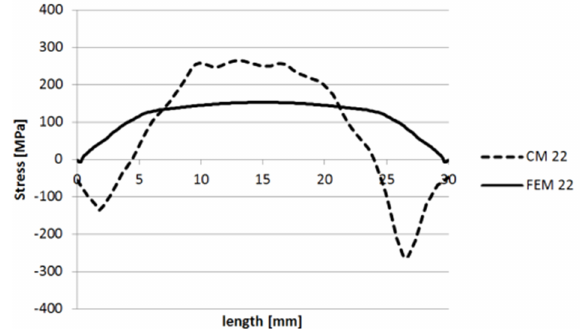
Figure 35. Stress levels in 22 direction along the CD line